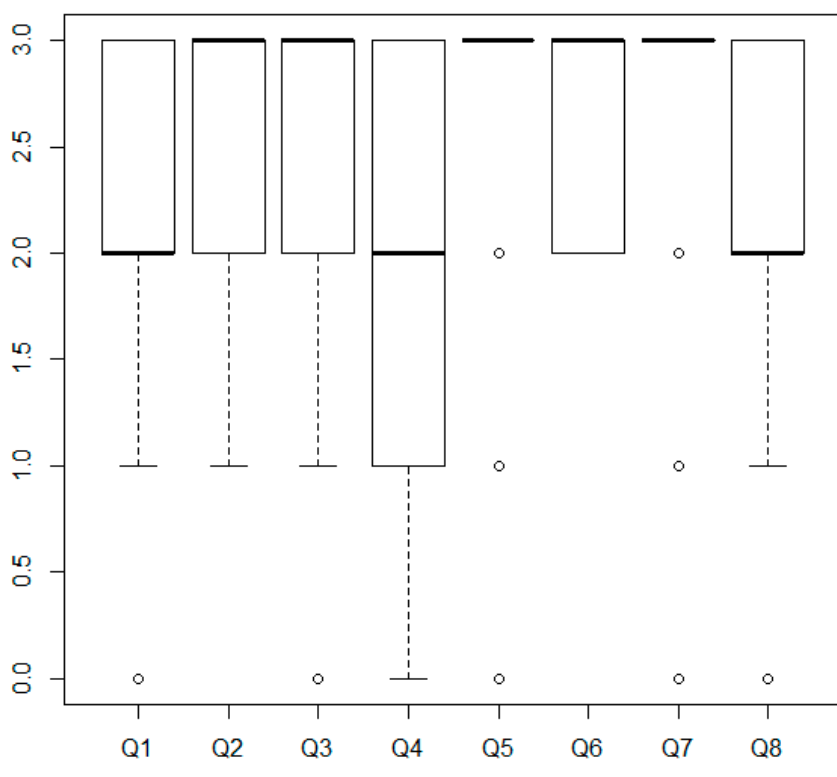
Figure 1. Collaborative reading: Distribution of responses.